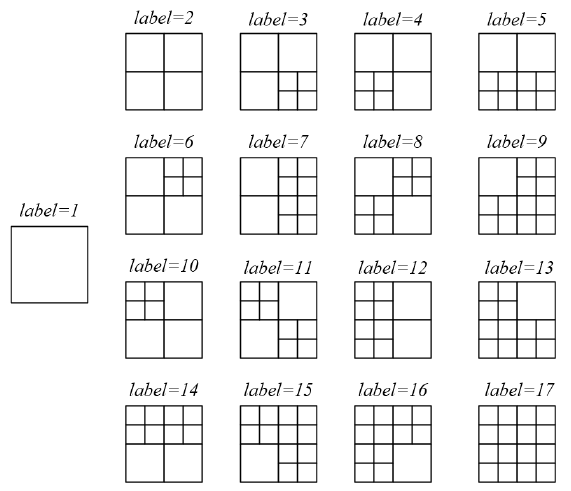
Figure 11. Class labels and corresponding partition structures of a 32 × 32 CU for ResNet multi- classification. Variate label is the class index of different partitions for a CU of size 32 ×